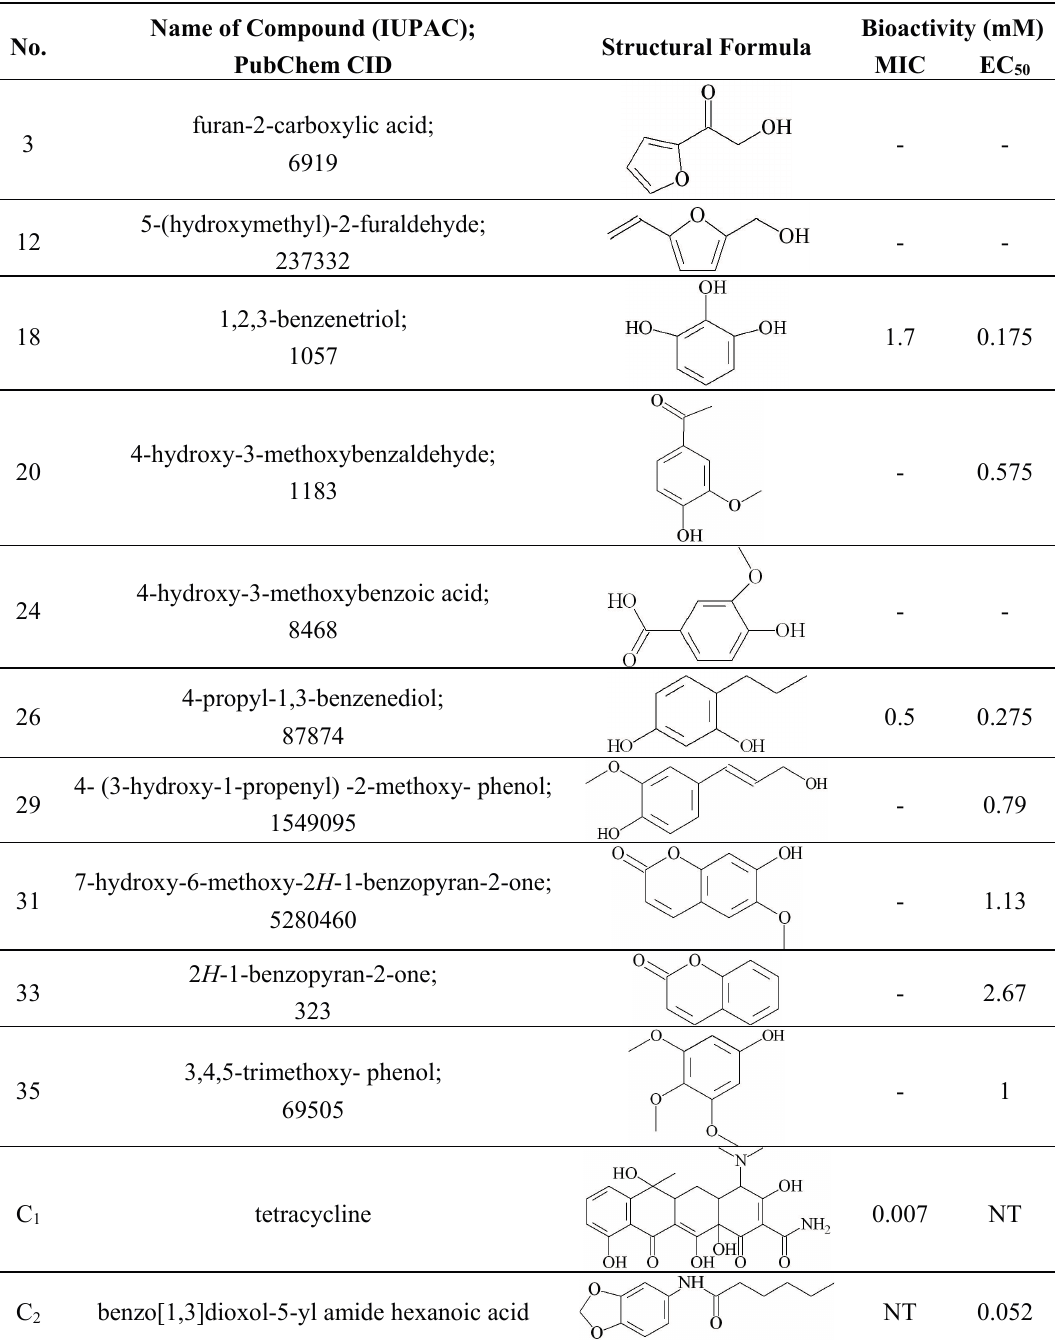
Table 2. Bioactivity of selected compounds presented as minimal inhibitory concentration (MIC) and effective concentration (EC 50 ) that inhibited 50% of violacein production in a C. violaceum CV026